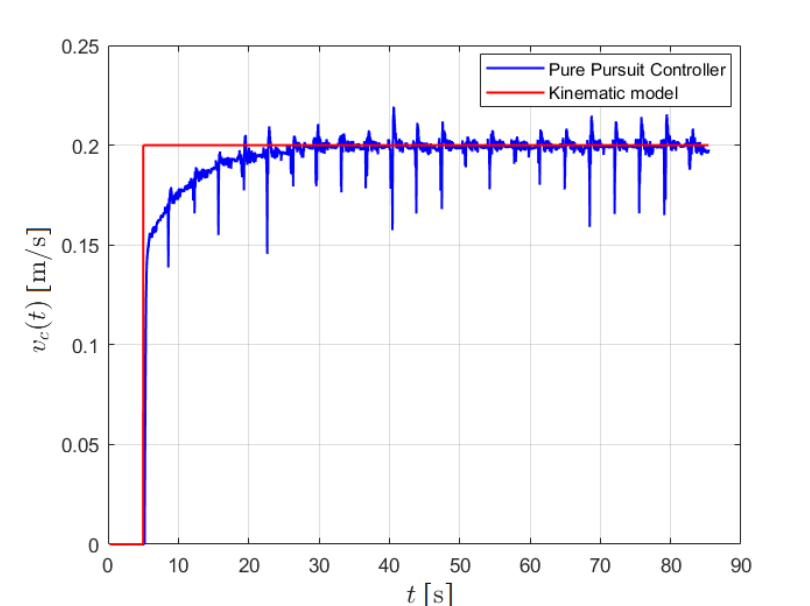
Figure 31. Linear velocity v c ( t ) of the robot.